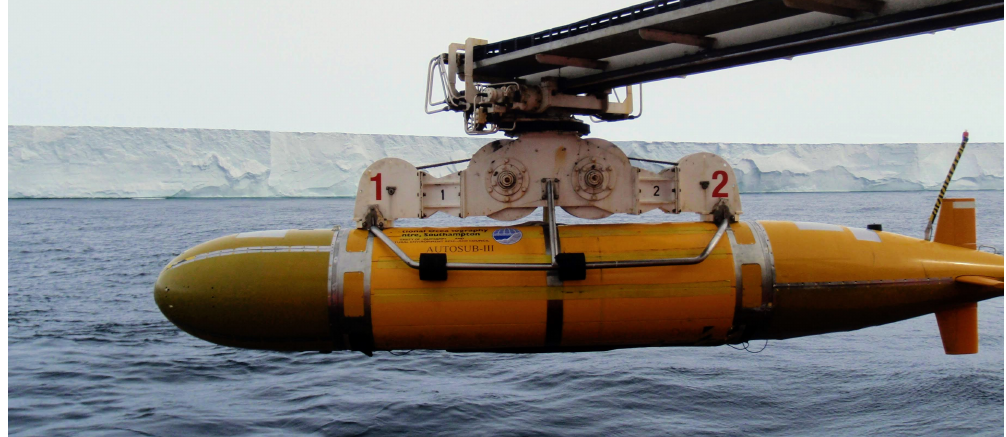
Figure 3. AUV Autosub 3 aboard the R/V Nathaniel B. Palmer after successful missions under Pine Island Glacier (background), Amundsen Sea, Western Antarctica, in 2009. Image Credit: Pierre